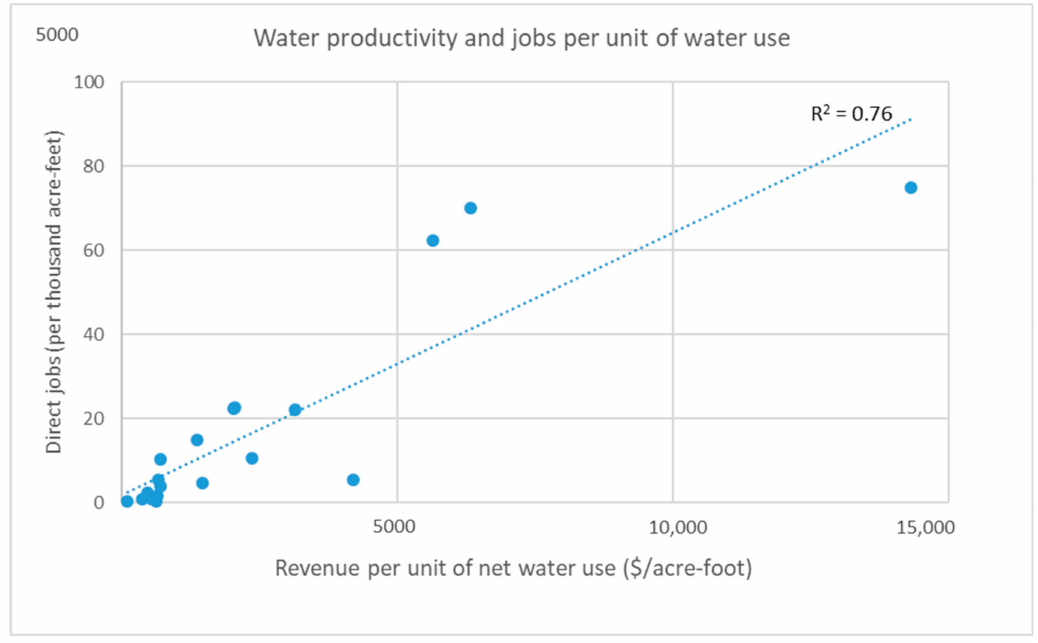
Figure 6. Direct farm labor jobs per unit net water use, state of California. Authors’ calculations and [10]. Contract labor is 96% of total direct labor jobs. 2005 U.S.